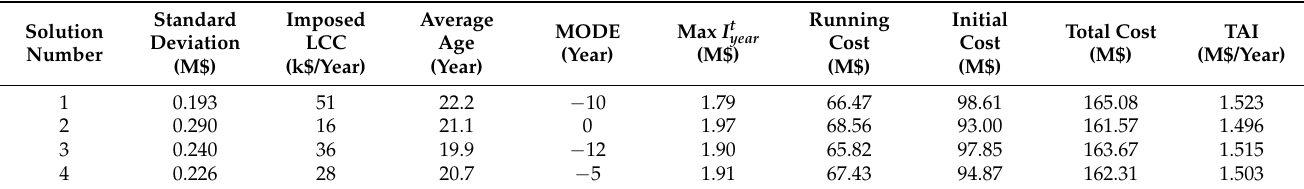
Table 6. Details of four selected points for Scenario 3 (replacement time boundary = ± 16 years, annual budget limit = 2.0 M$).